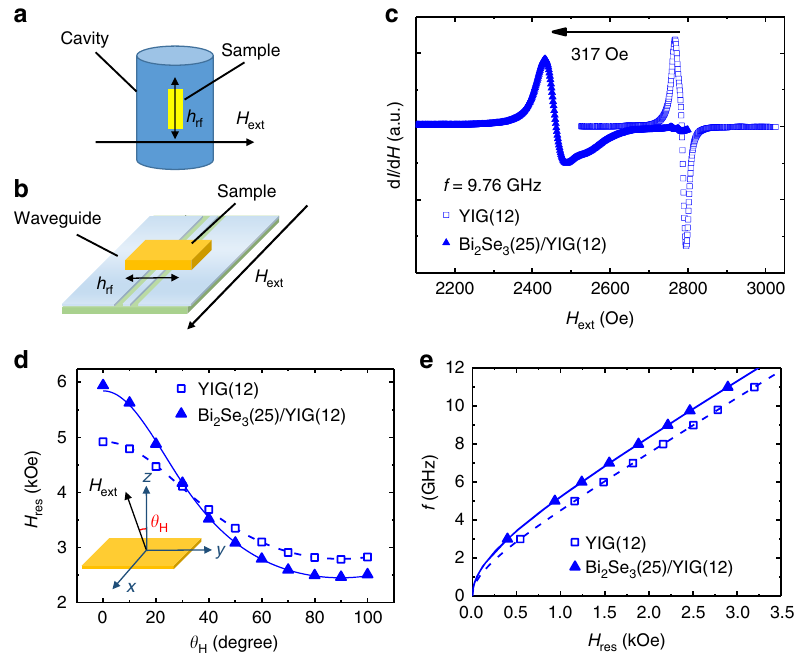
Fig. 1 Schematic diagrams and results of the angle- and frequency-dependent FMR measurements. a , b FMR using the cavity and co-planar waveguide con fi guration for angle- and frequency-dependent study, respectively. A dc external fi eld H ext was applied and h rf denotes the microwave fi eld. c FMR spectra of Bi 2 Se 3 (25)/YIG(12) and YIG(12) measured by the cavity. d , e θ H and f dependence of H res of Bi 2 Se 3 (25)/YIG(12) and YIG(12),